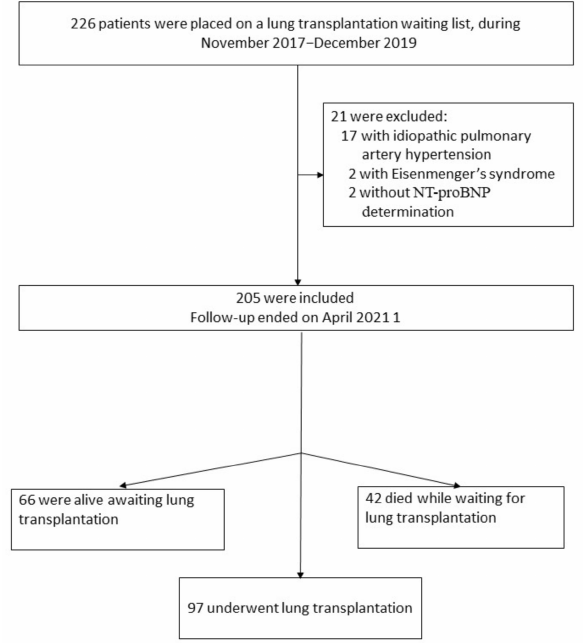
Figure 1. Flowchart presenting the study